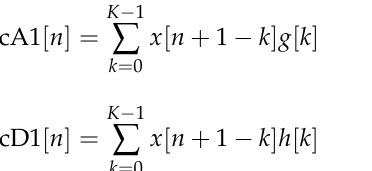
Figure 3. The audio decomposition process.